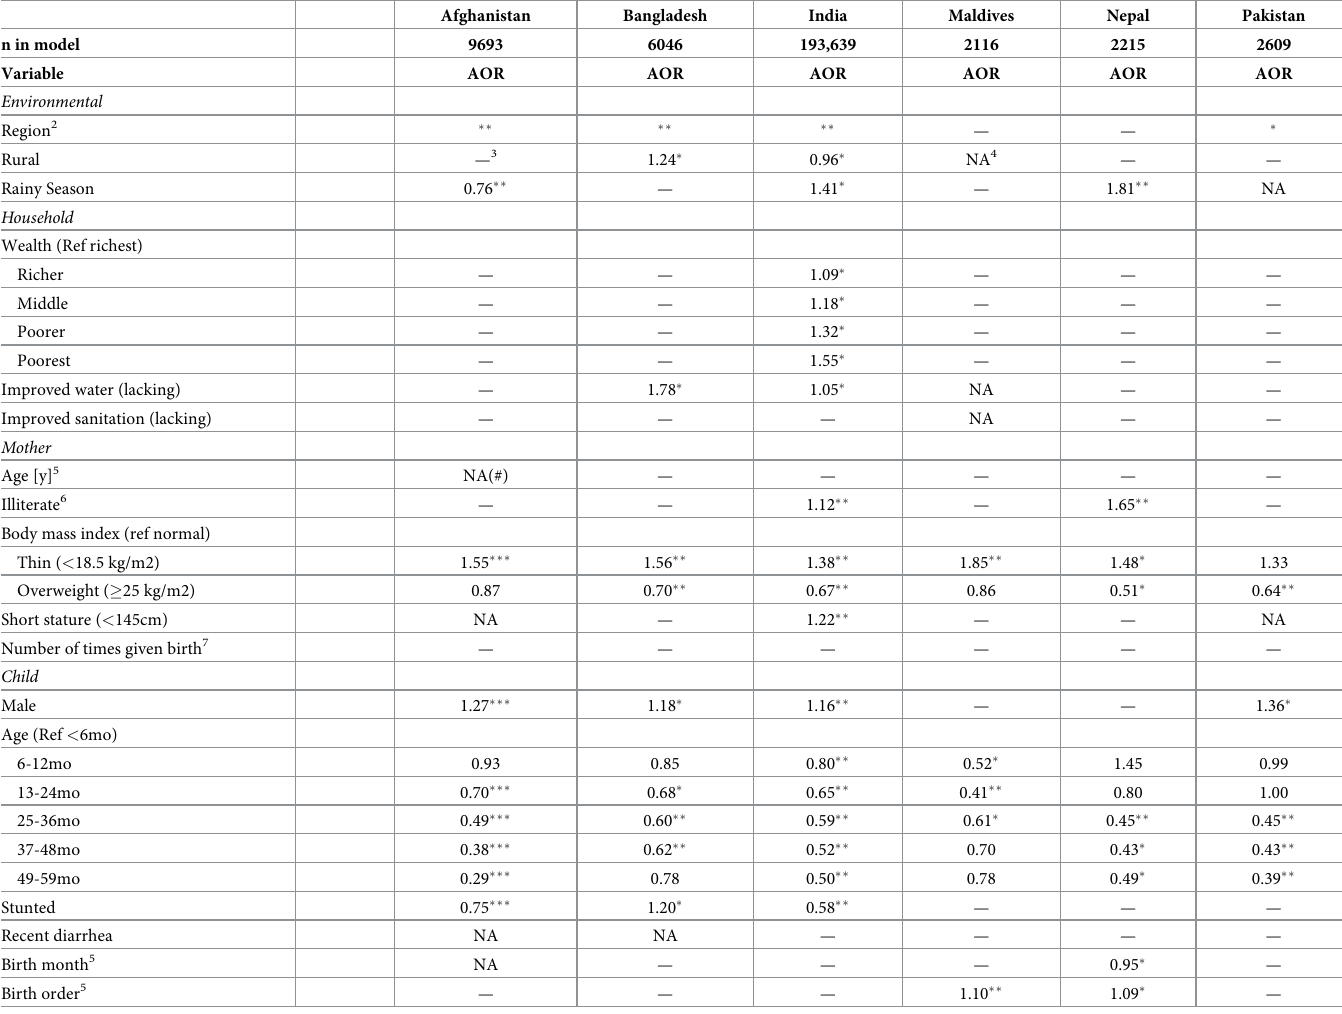
Table 3. Adjusted odds ratios (AORs) of wasting among children in South Asia and by country 1 .